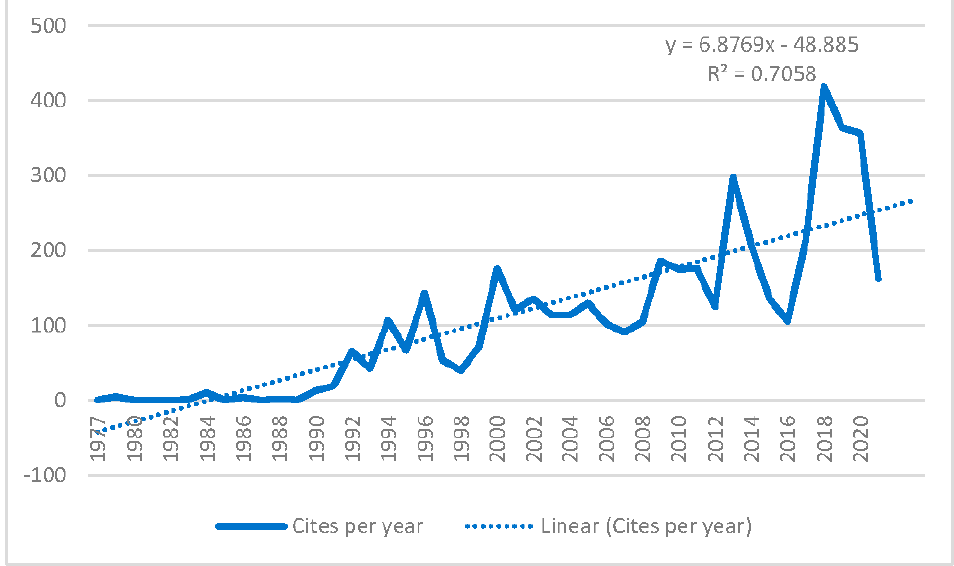
Figure 4. Intertemporal evolution of citations per year. Table 3. High-impact